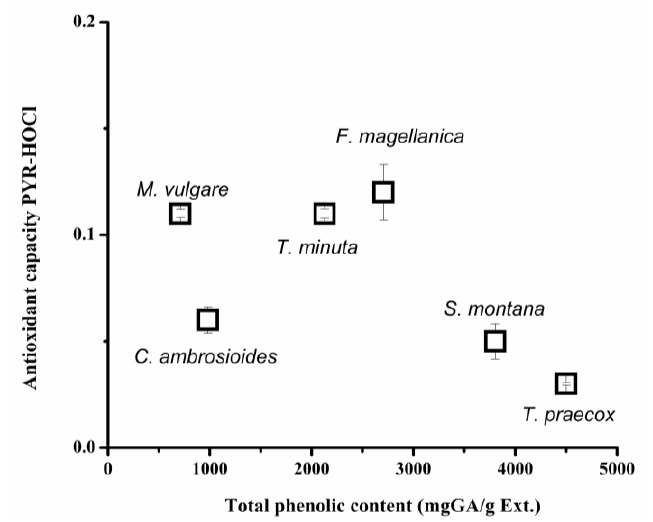
Figure 8. Dependence of the PYR-HOCl index with total phenol content of plant extracts.